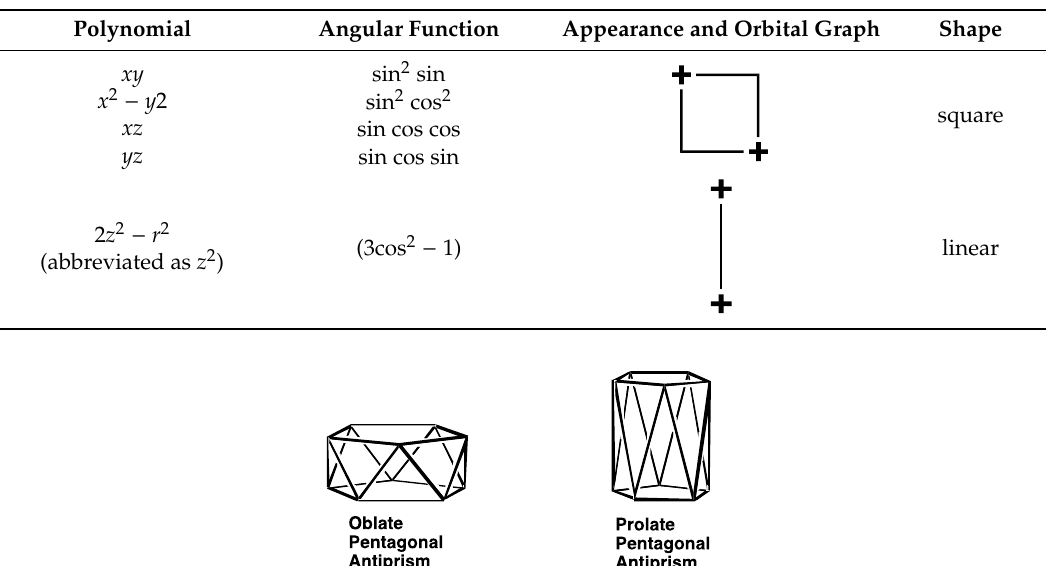
Table 1. The polynomials, angular functions, and orbital graphs for the five d orbitals.